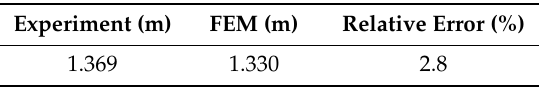
Table 1. Tip deflections of a 100 kW blade.